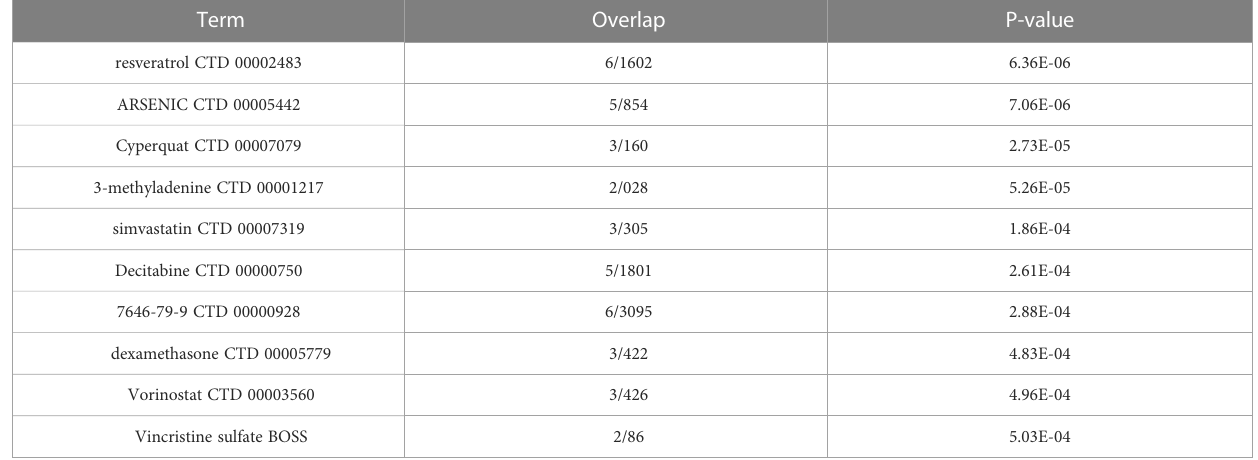
TABLE 1 Top 10 drug predictions of hub